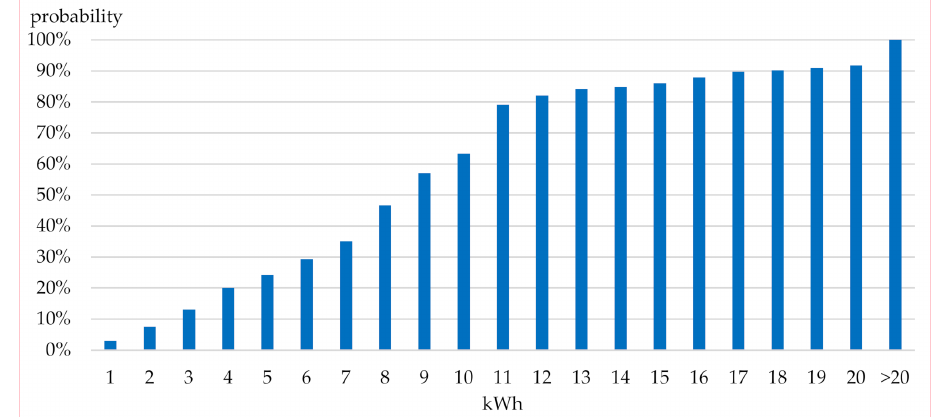
Figure 7. Cumulative distribution function of charging requirements [kWh] ([34], calculated by